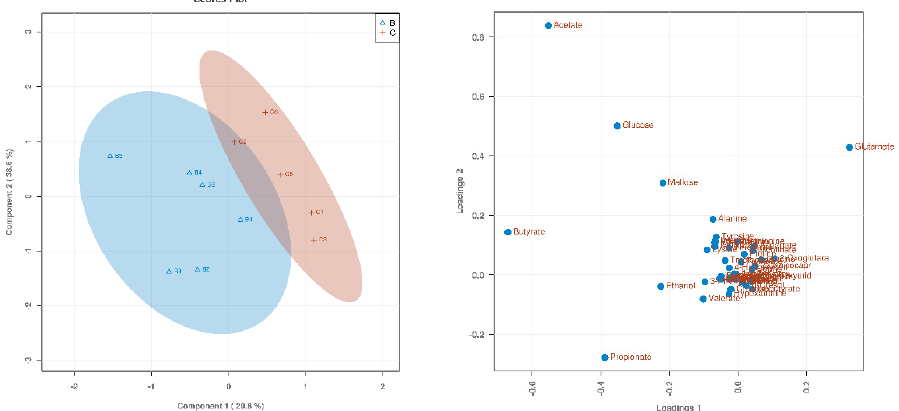
Figure 2. The score plot and loading plot of THR100 and THR125 from the PLS-DA analysis. The result is the picture below. The degree of separation in the score plot for this group was the most significant when compared with other groups.